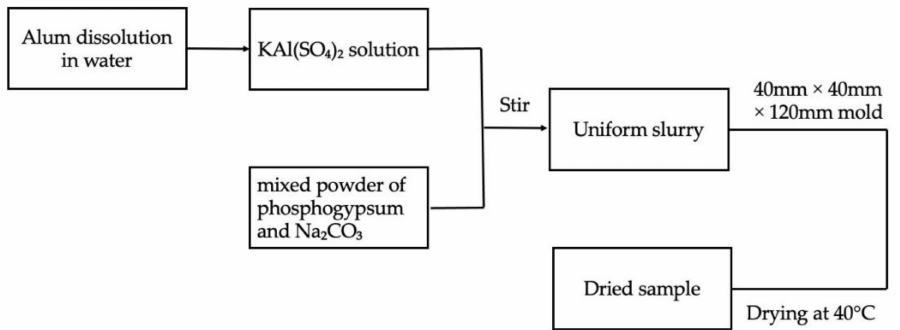
Figure 1. Sample preparation method